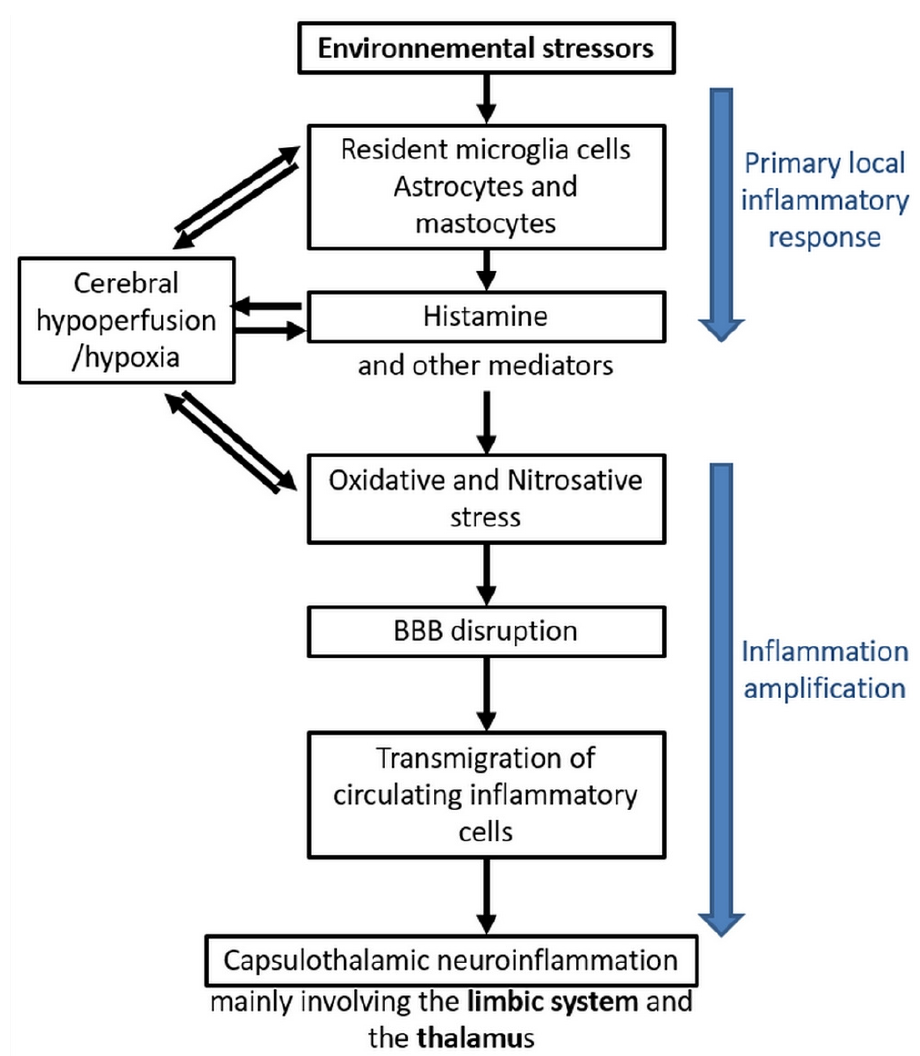
Figure 1. EHS/MCS physiopathological model based on low-grade neuroinflammation and oxida- tive/nitrosative stress-induced blood–brain barrier disruption, according to Reference [9].